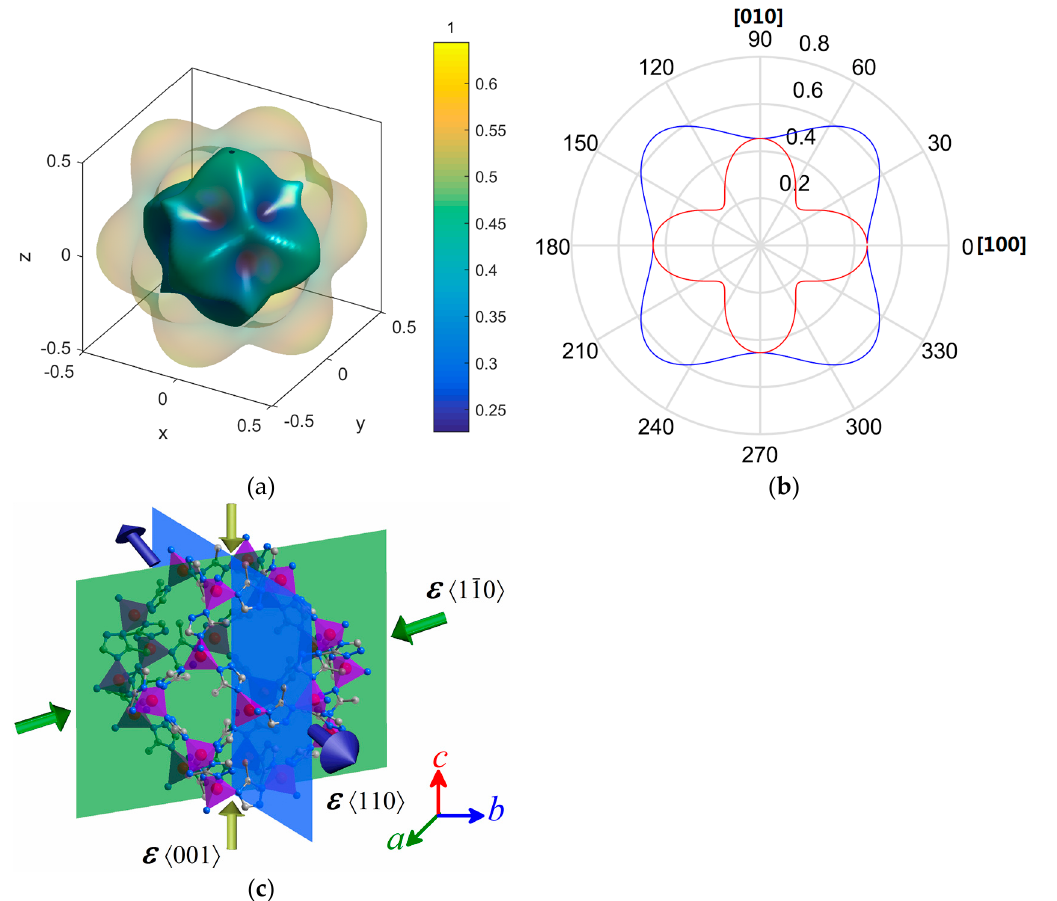
Figure 5. Poisson’s ratio ( ν ) representation surfaces. ( a ) and 3D ( b ) 2D surface based on the calculational C ij and corresponding polar plots obtained via projections through the origin and down the c axis, showing the positions of maximum and minimum modulus. ( c ) Axial and accompanying lateral directions that generate the positive ν max and ν min . Blue arrows represent the directions of loading, green and yellow arrows indicate contraction.